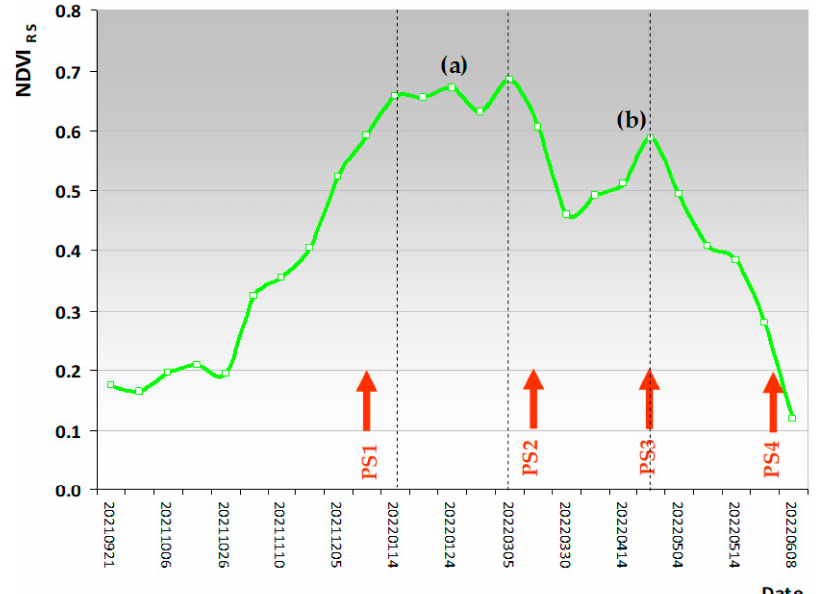
Figure 7. Normalized difference vegetation index (NDVI) time-series: mean of the records obtained by remote sensing (RS) between 21 September 2021 and 8 June 2022. The arrow indicated the four dates of pasture sampling (from PS1 to PS4). (a) NDVI stable period; (b) NDVI recovery.